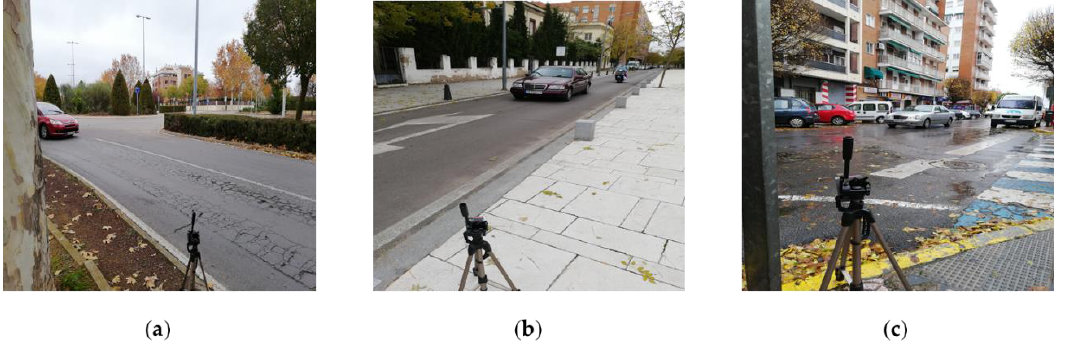
Figure 12. Examples of installed sensor at strategic points: ( a ) Exit from an intersection and enter a link with two lanes; ( b ) Link with a single lane with unidirectional flow; ( c ) Entrance to a link with a single lane.